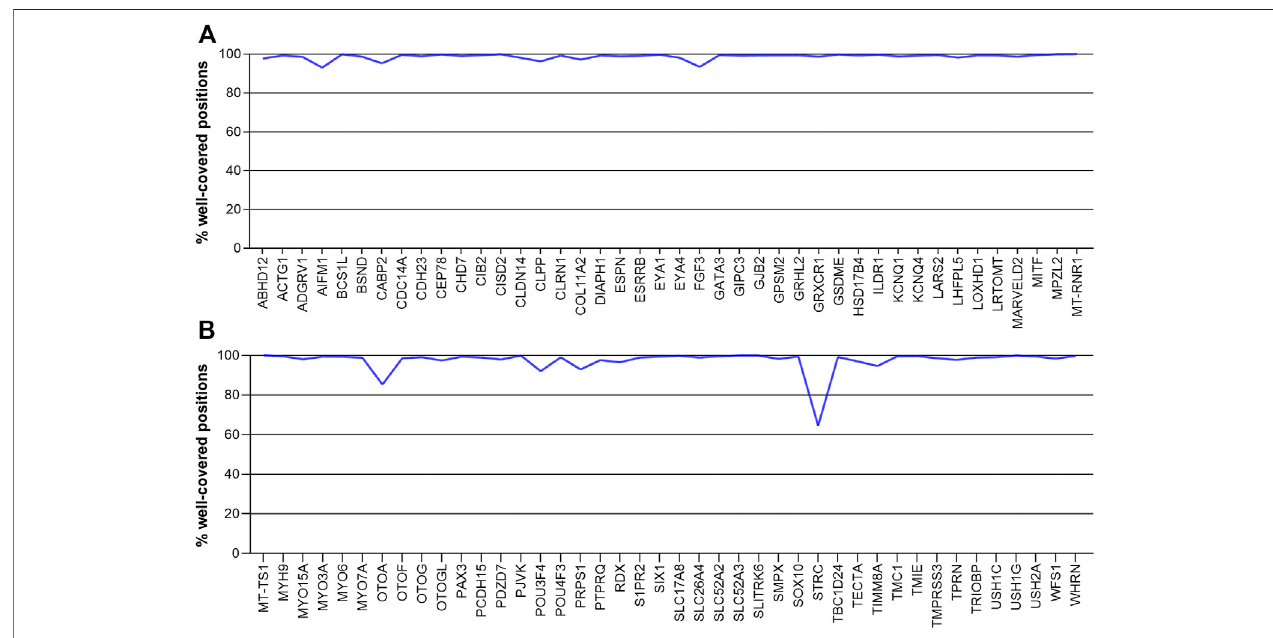
FIGURE 3 | The coverage of deafness-related genes in our sequencing, showing the percentage of gene positions that are well covered. Genes are arranged in alphabetical order. (A) ABHD12 - MT-RNR1 (B) MT-TS1 - WHRN .